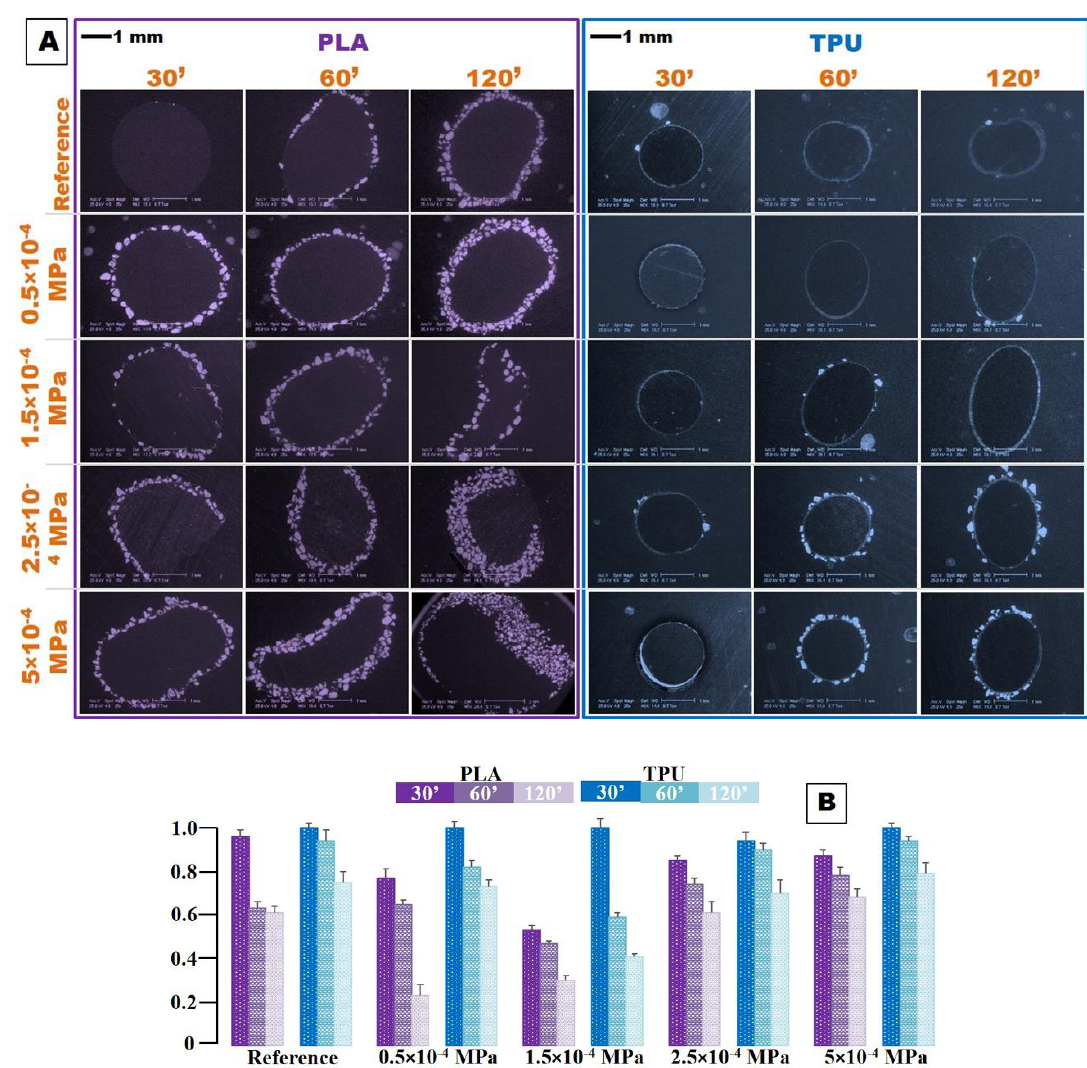
Figure 5. Form factor variation at 195 °C temperature. ( A ) Section morphology; ( B ) variation graphs. 263